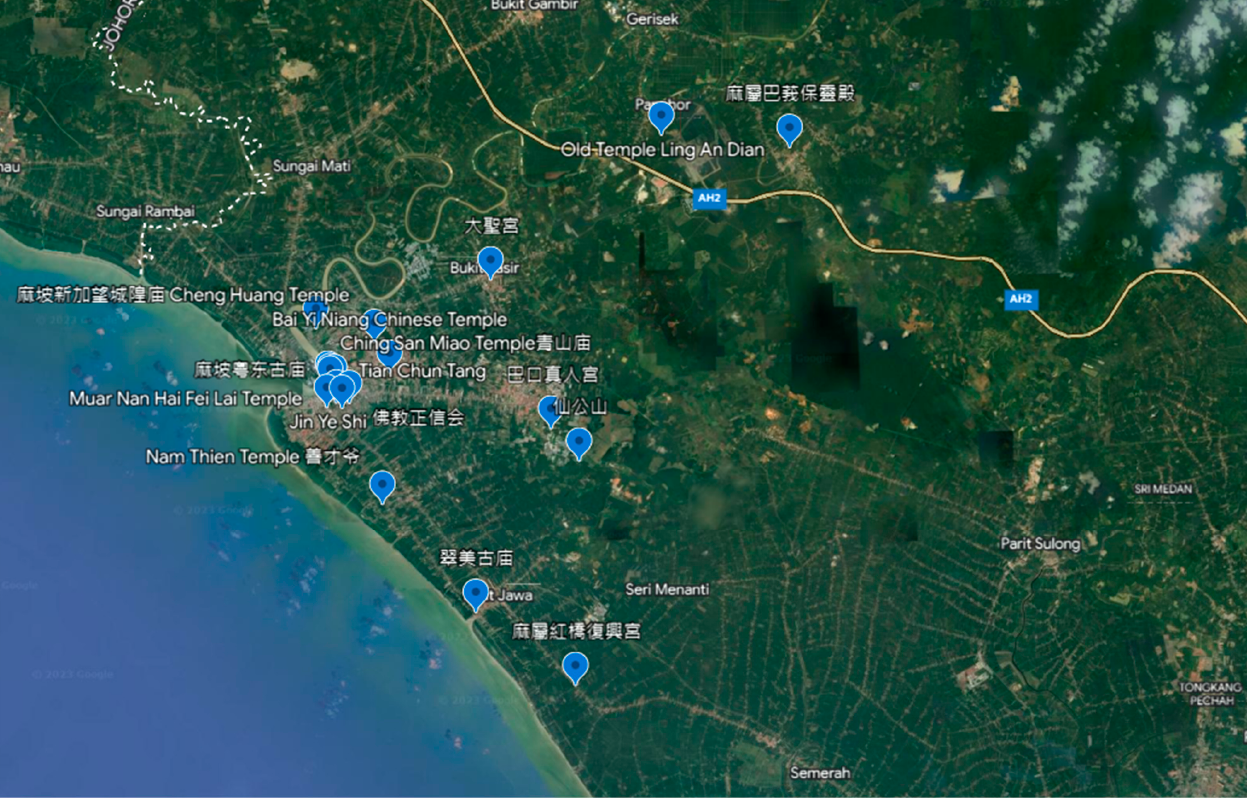
Figure 4. Muar Temples Distribution Map in 1850–1999.